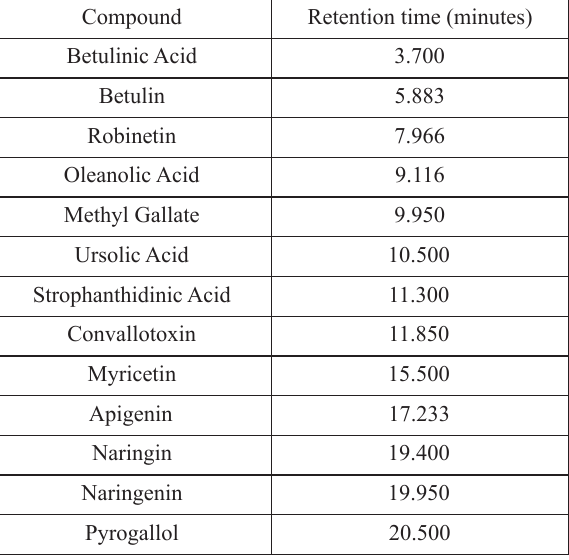
Identified phytochemicals in the chromatogram